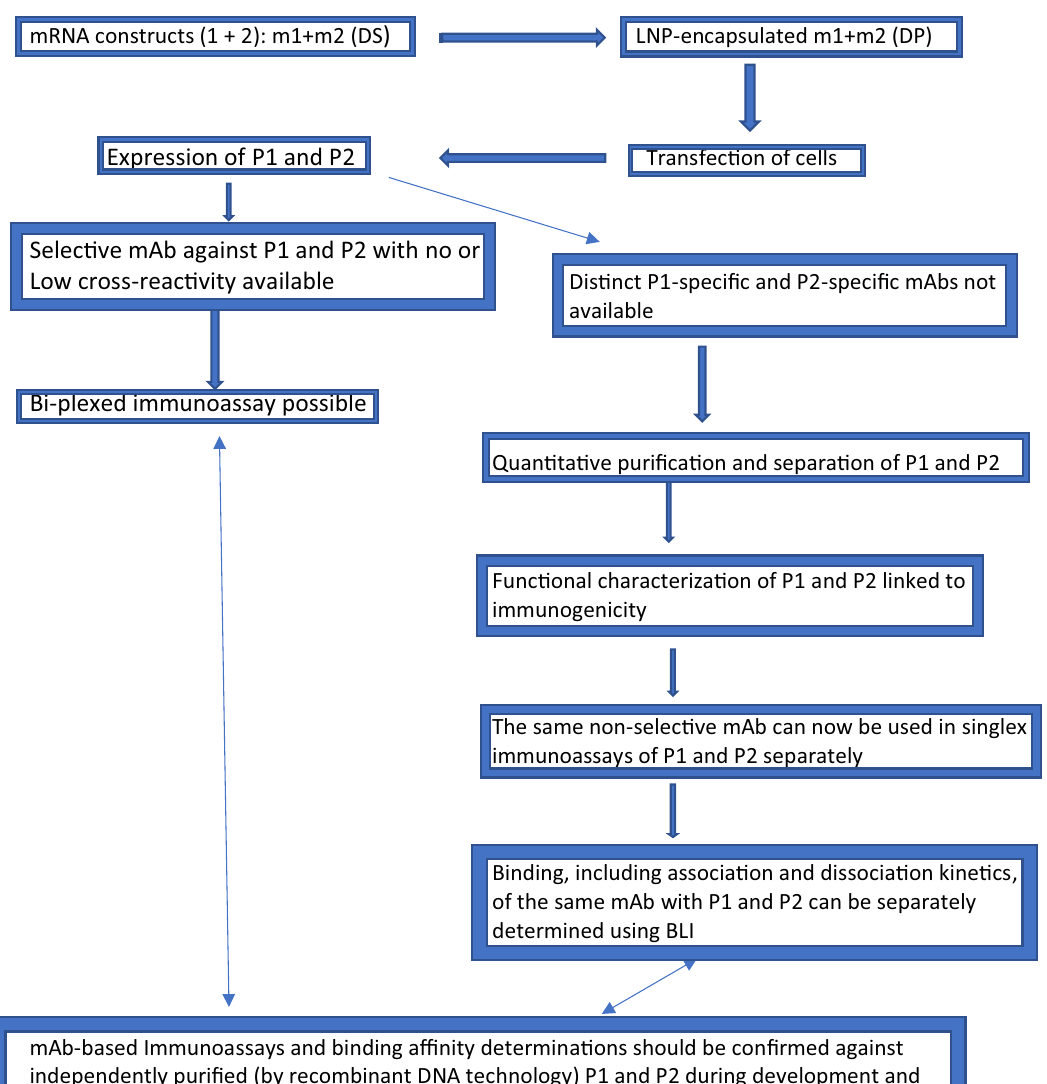
Fig. 1 A stepwise scheme for designing potency assays for a multivalent mRNA vaccine product in fi nal formulation using bivalent mRNA constructs as a model. m1 and m2 represent mRNA construct 1 and mRNA construct 2, respectively. P1 and P2 represent proteins encoded by m1 and m2,